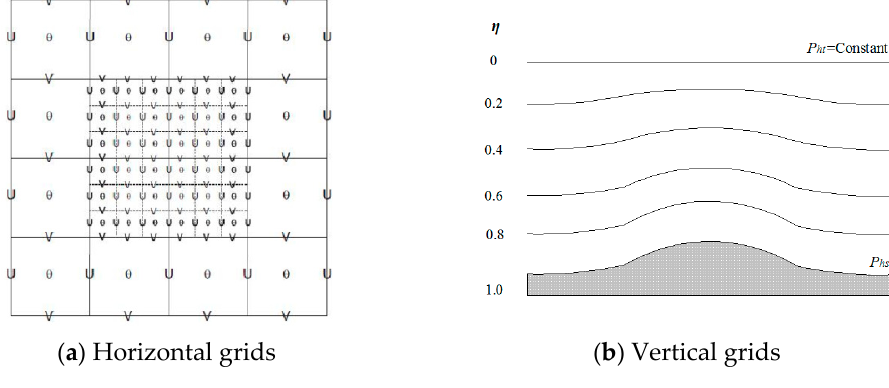
Figure 1. Meshing sketch of WRF mode.